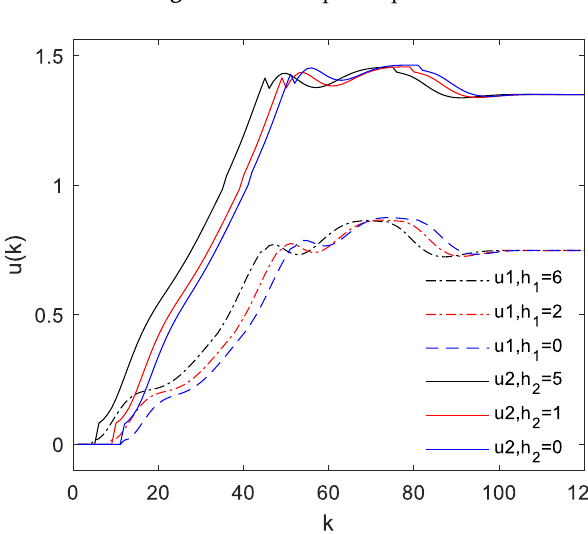
Figure 7. The output response.